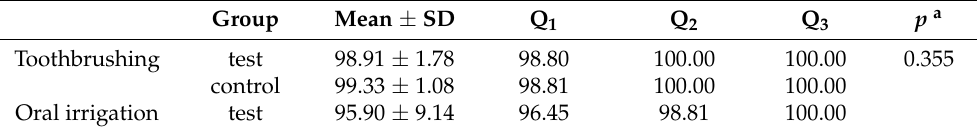
Table 6. The compliance of participants in two groups (full analysis set). Group p a Toothbrushing